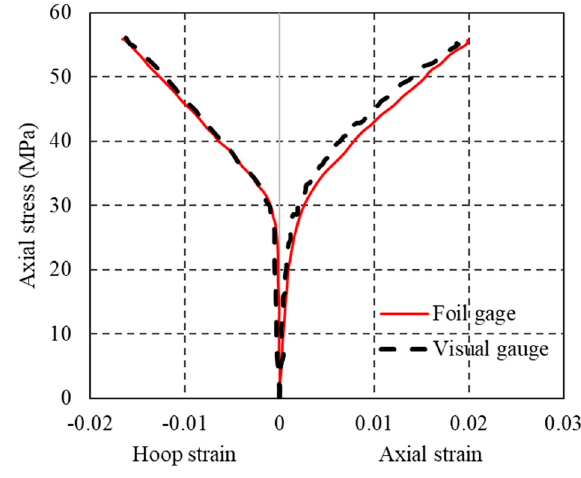
Figure 5. Stress-strain curves of FRP-confined concrete from visual and foil gauges.